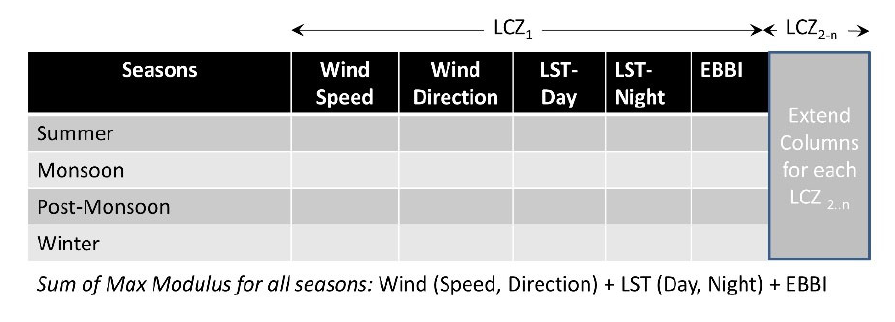
Table 3. Criteria for category assignment to the grid.